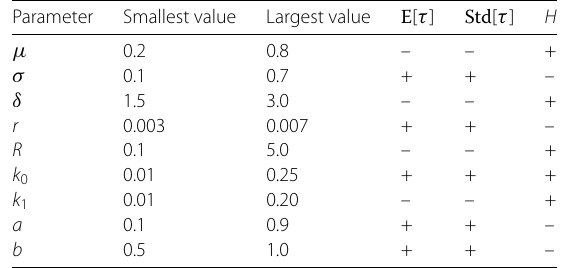
Figure 13 Dependence of E [ τ ] (red), Std [ τ ] (blue), and H (green) on μ